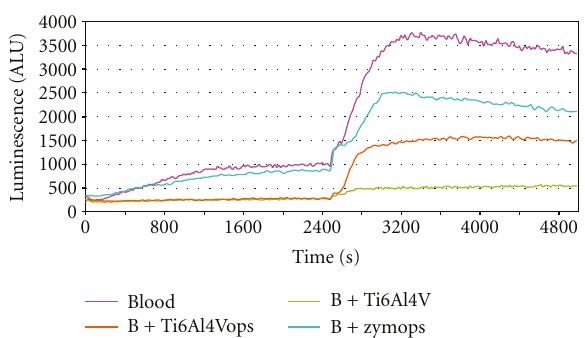
Figure 2: Chemiluminescence response of whole blood cells to Ti6Al4V, opsonised and nonopsonised, and opsonised zymosan (positive control). Reaction mixture included whole blood cells without particulate materials (negative control) and in the presence of Ti6Al4V, Ti6Al4Vops, and Zymops particles. Cells were stimu- lated with fMLP+PMA at 2400 s.